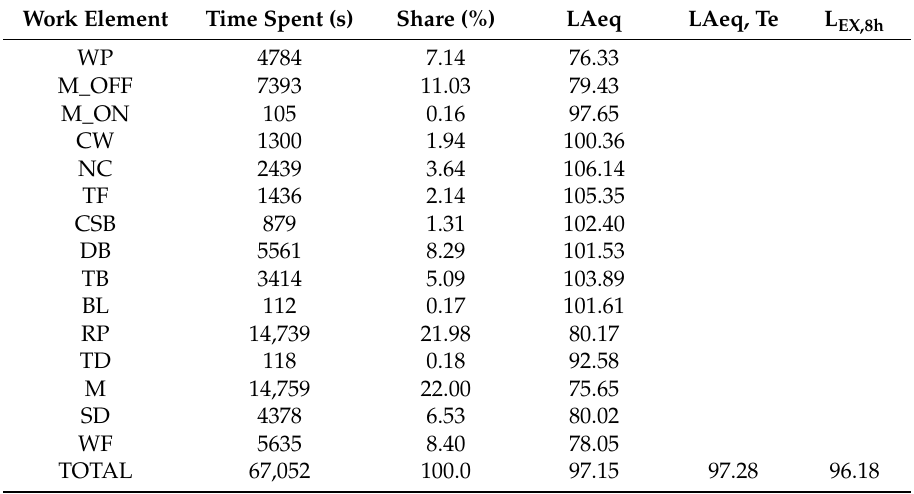
Table 5. Breakdown of duration and levels of exposure to noise by tasks and for the study. Work